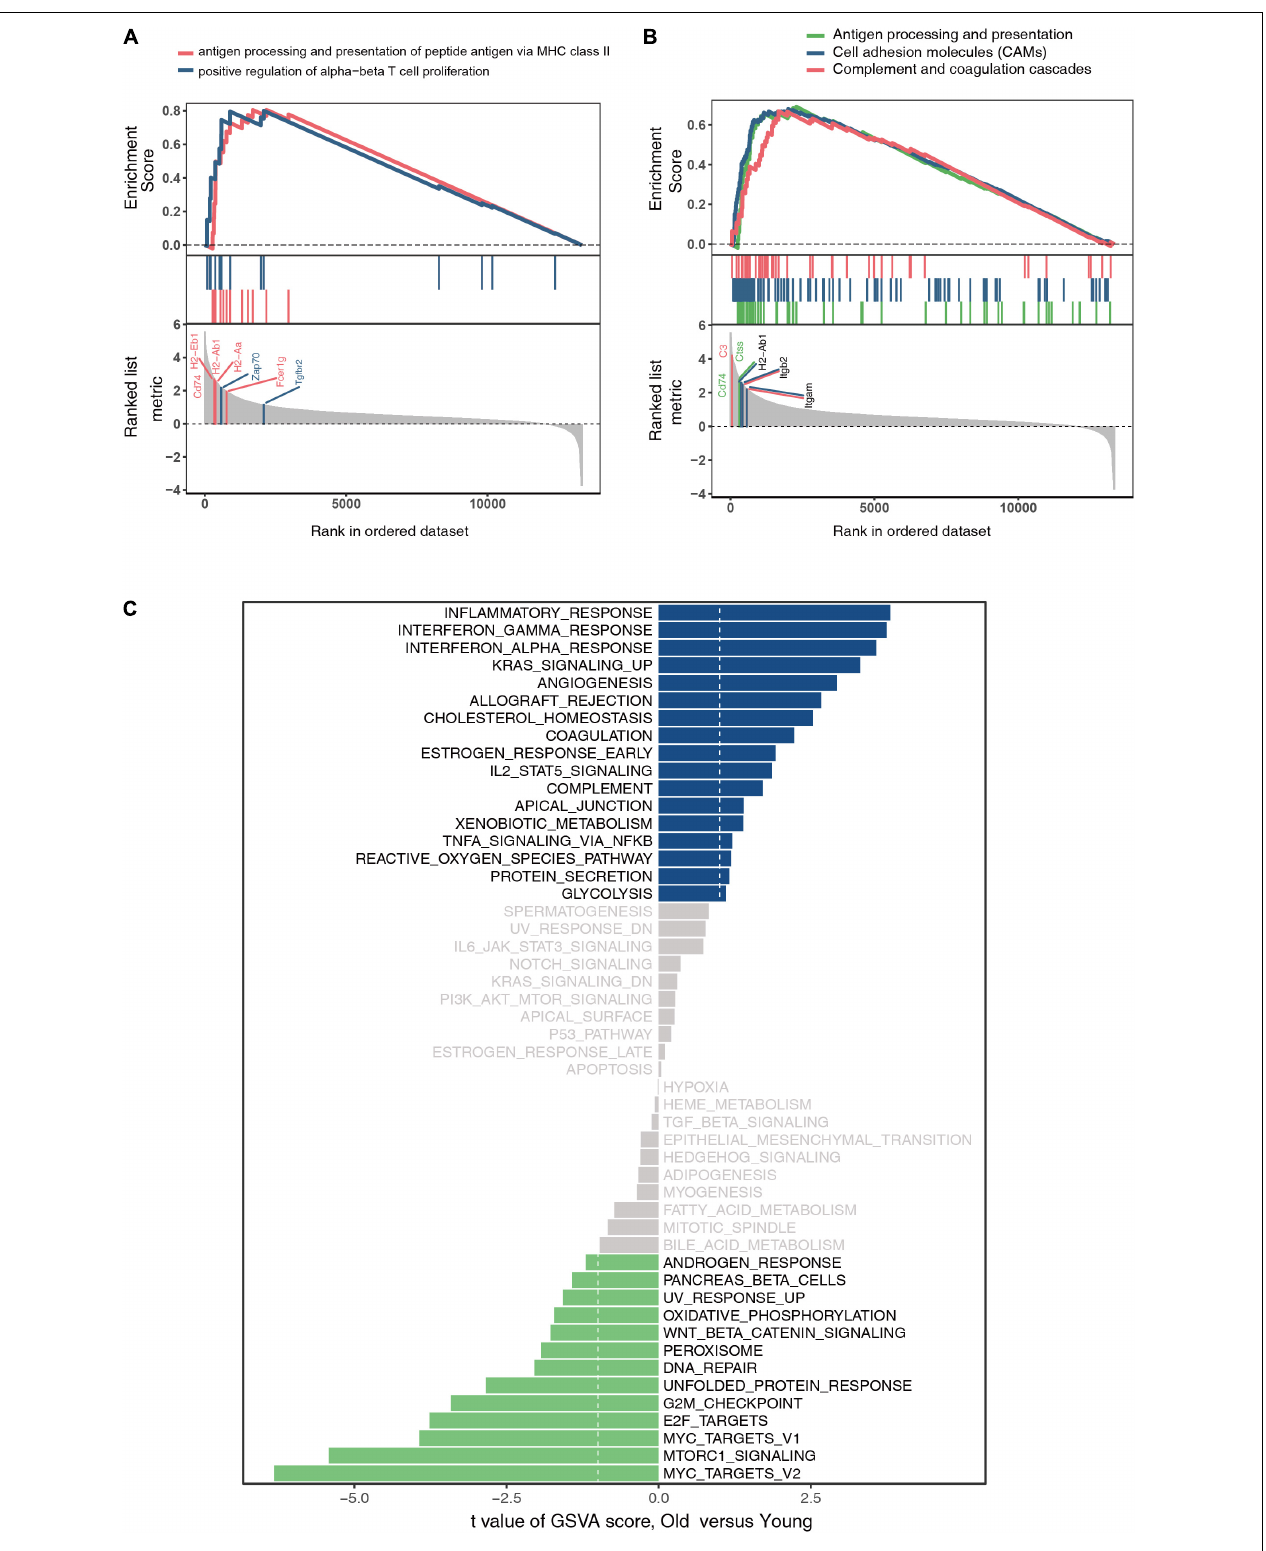
FIGURE 4 | Gene set enrichment analysis of GO terms (A) . Gene set enrichment analysis of KEGG pathways (B) . Gene set variation analysis and the differentially expressed analysis of pathways (C) .